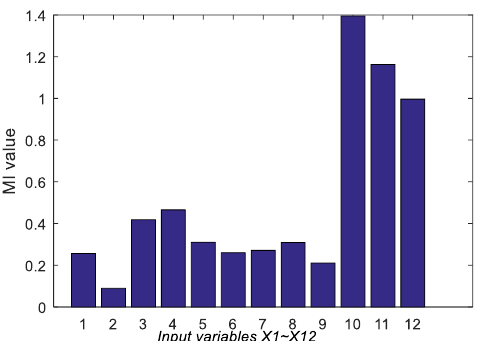
Figure 5. MI values between 12 input variables and y.